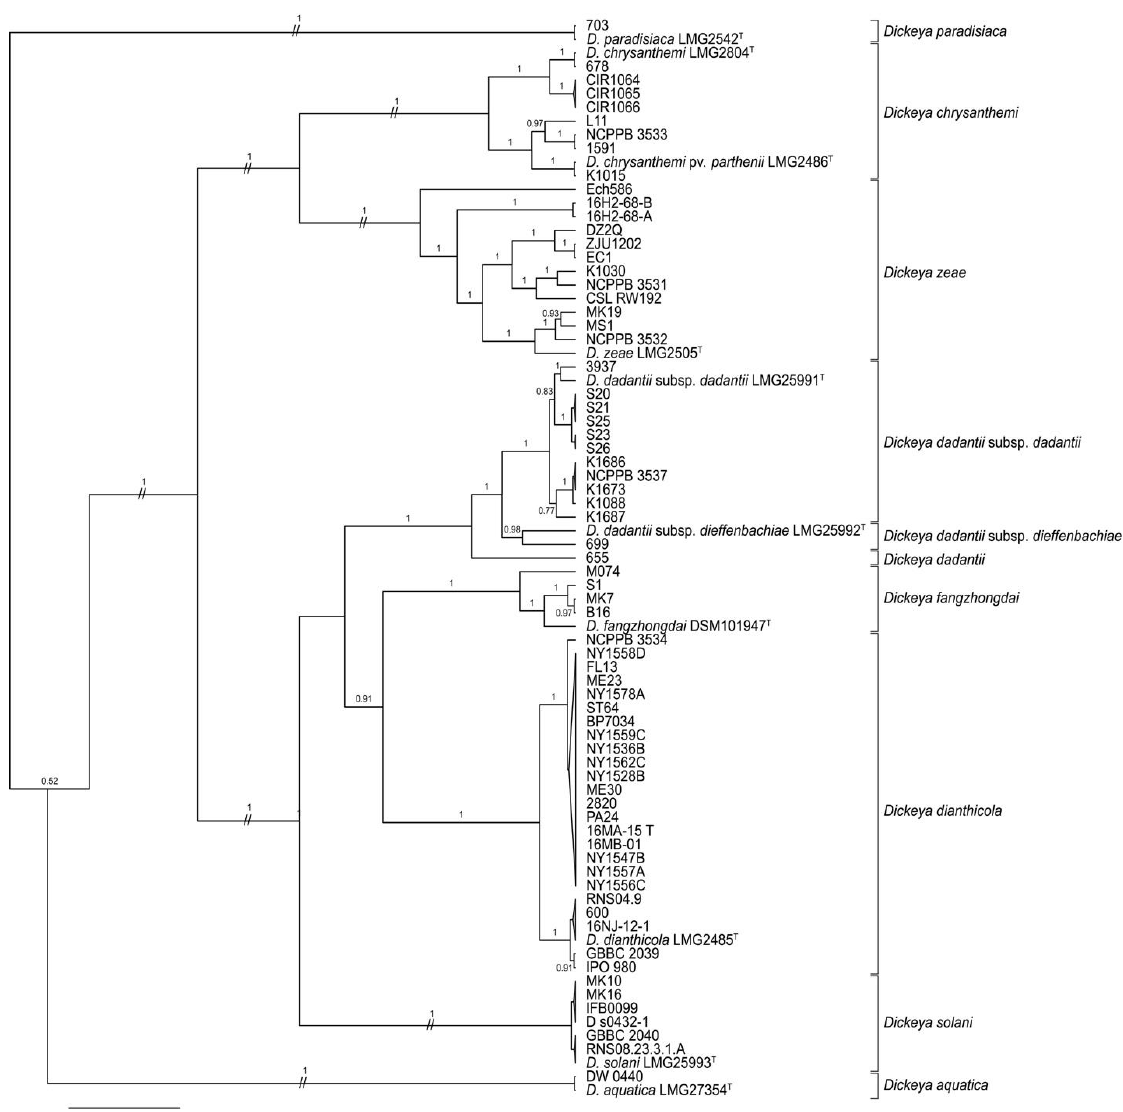
Figure 1. Bayesian tree of Dickeya spp. constructed from concatenated sequences of fragments of the genes dnaJ , dnaX , and gyrB of 29 strains collected in 2015 – 2016, 10 type strains, and 40 historic reference strains. The superscript letter T indicates the species type strain. Posterior probabilities > 0.6 are shown at the corresponding node. Branch lengths are drawn to scale and represent sequence changes since the common ancestor.